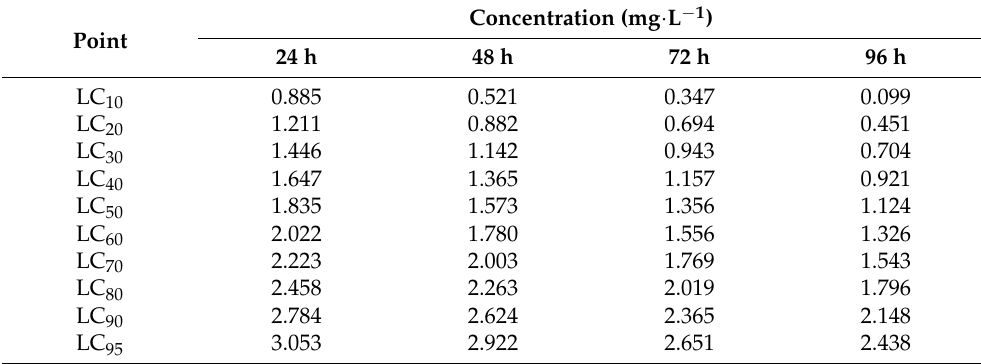
Table 1. Lethal concentration (LC 50 ) of diazinon (DZN) for grass carp fingerlings ( Ctenopharyngodon idella ). Point